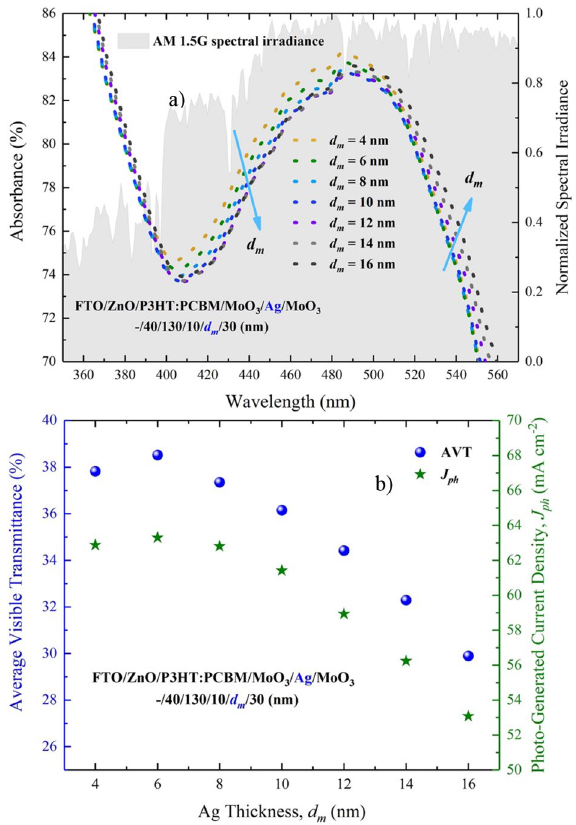
Figure 5. For FTO/ZnO/P3HT:PCBM/MoO 3 /Ag/MoO 3 (–/40/130/10/ d m /30 nm) ST-OSC; ( a ) absorbance spectrum and, ( b ) changes of AVT and J ph according to d m